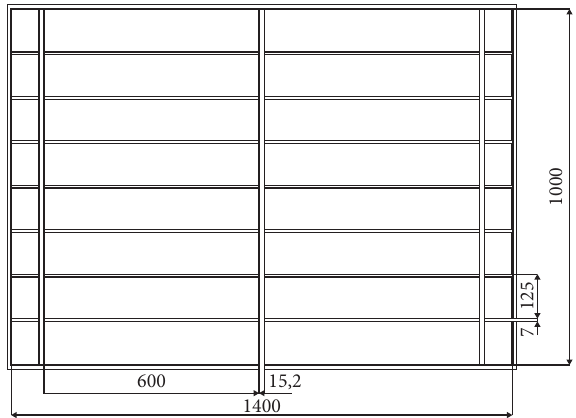
Figure 1: Target plate structure